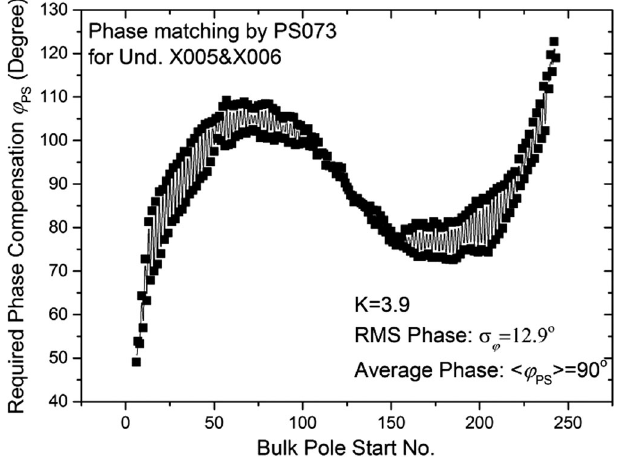
FIG. 9. Phase compensation as a function of the pole number where the bulk field starts.